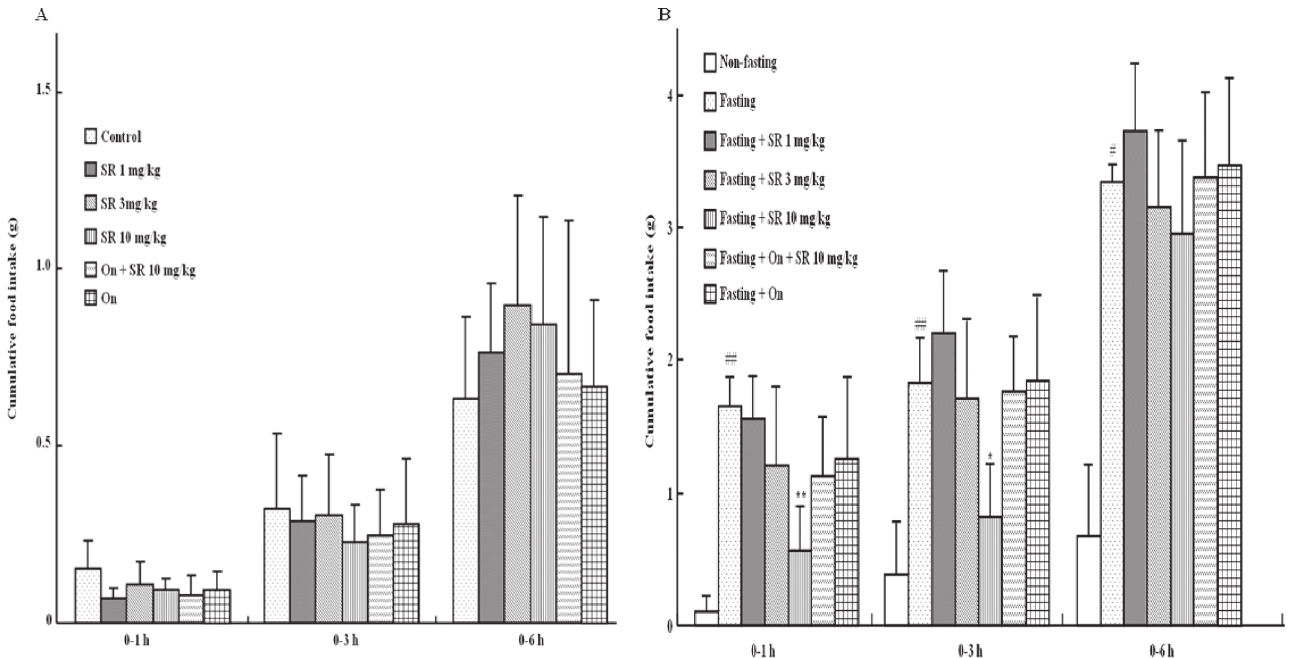
Fig 1. Effects of acute SR 57227 on cumulative food intake in fed and fasted mice. SR: SR 57227 (1, 3 and 10 mg/kg, i.p.); On: ondansetron (3 mg/kg, i. p.). Values are means ± SEM (n = 8 – 10). #, P < 0.05; ##, P < 0.01 vs. non-fasting group; * , P < 0.05; ** , P < 0.01 vs. fasting group.